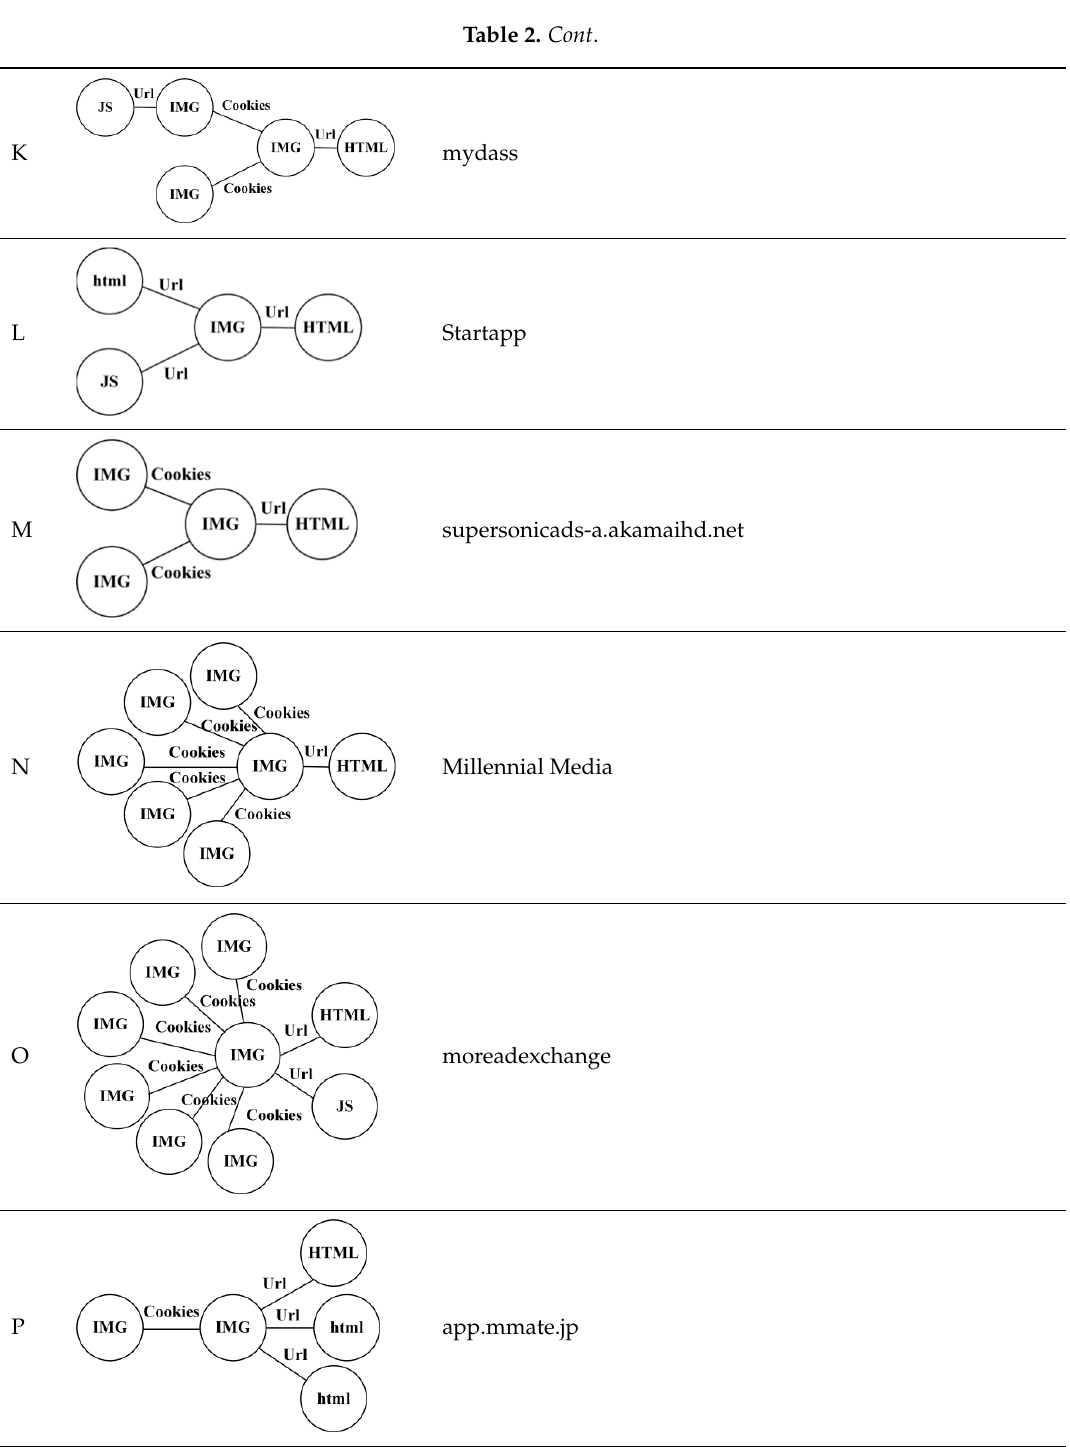
Table 2. Graph types and their corresponding ad libs (with graph as index).